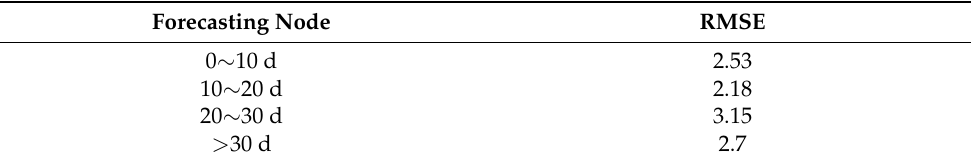
Table 6. Prediction results in different growth stages of leafy greens.